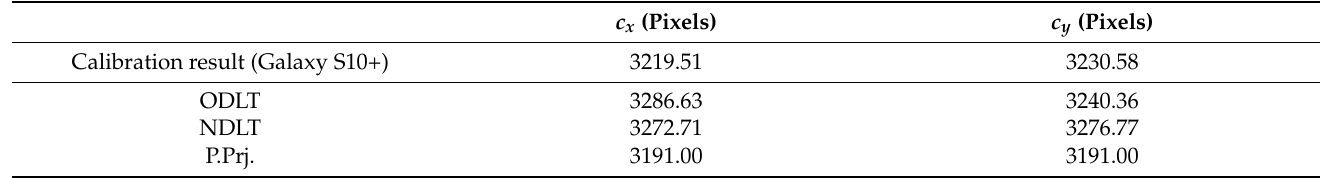
Table 8. Calibration result and estimated principal distance of a smartphone.